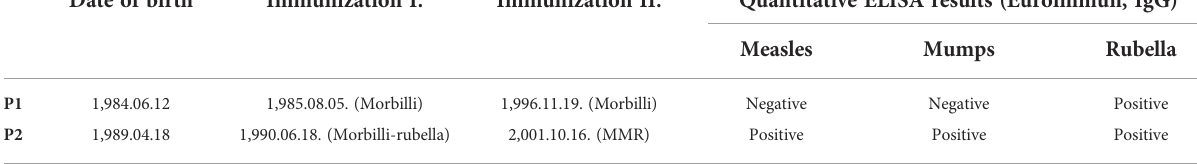
TABLE 3 Patients ’ data and qualitative MMR ELISA (IgG)